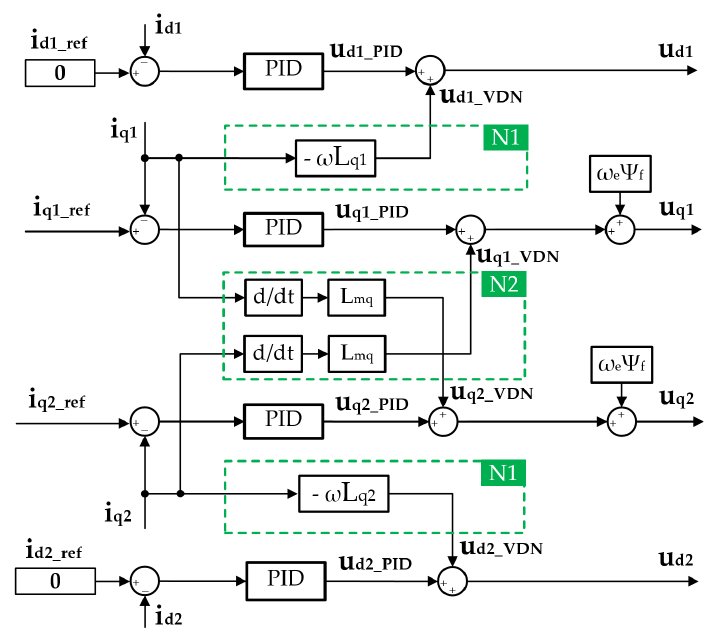
Figure 9. Block diagram of the inner current control loop with decoupling network.